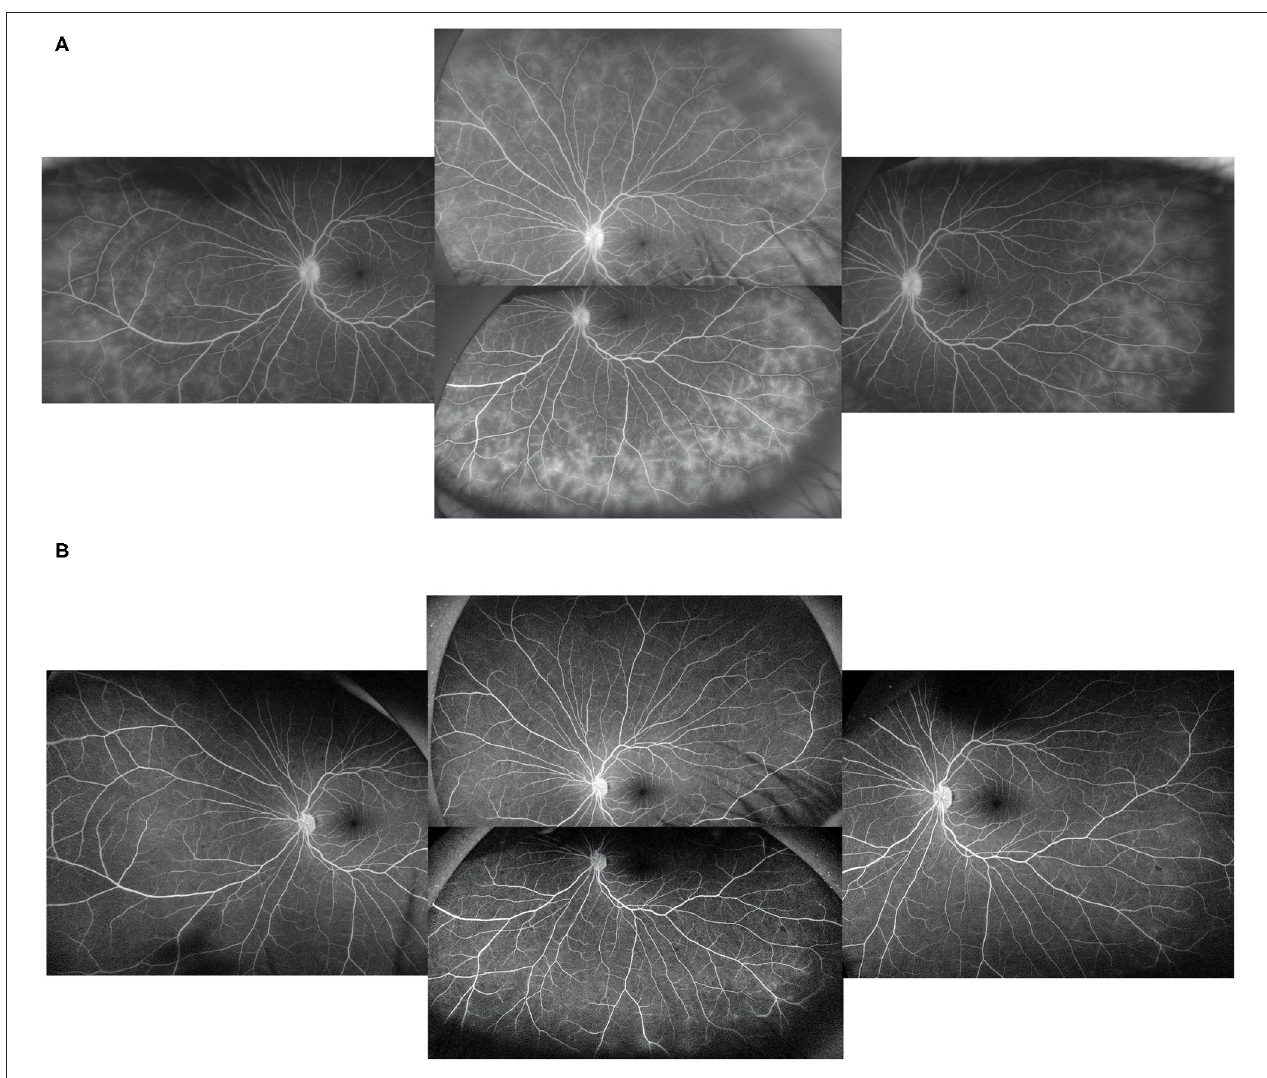
FIGURE 2 | In a patient with peripheral vascular leakage at baseline (A) , 3 months of adalimumab treatment led to complete alleviation of vascular leakage (B)